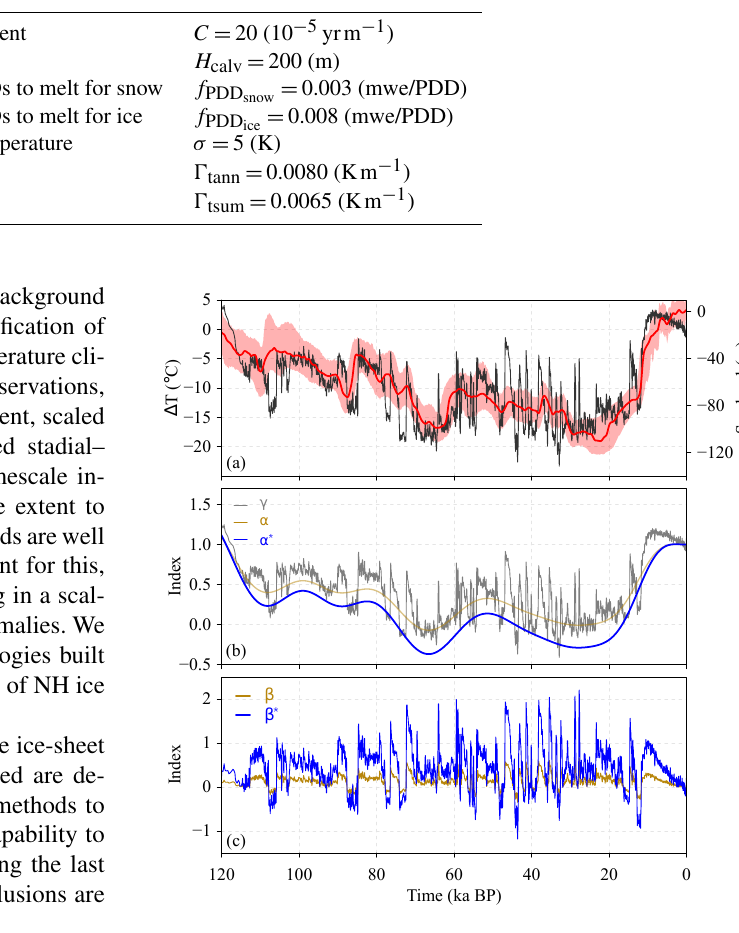
Figure 1. Temporal components of the three forcing methods. (a) Sea-level forcing (m) as estimated by Grant et al. (2012). The light red shaded area represents the 95% confidence level interval of the prescribed sea-level reconstruction. The black curve shows the evolution of temperature anomalies ( ◦ C) relative to the present over Greenland from which the index is derived (Vinther et al., 2009; Kindler et al., 2014). (b) Index used in M1 ( γ ; gray) together with the orbital components of the indices used in M2 ( α ; gold) and M3 ( α (cid:63) ; blue). (c) Millennial components of the index used in M2 ( β ; gold) and M3 ( β (cid:63) ;